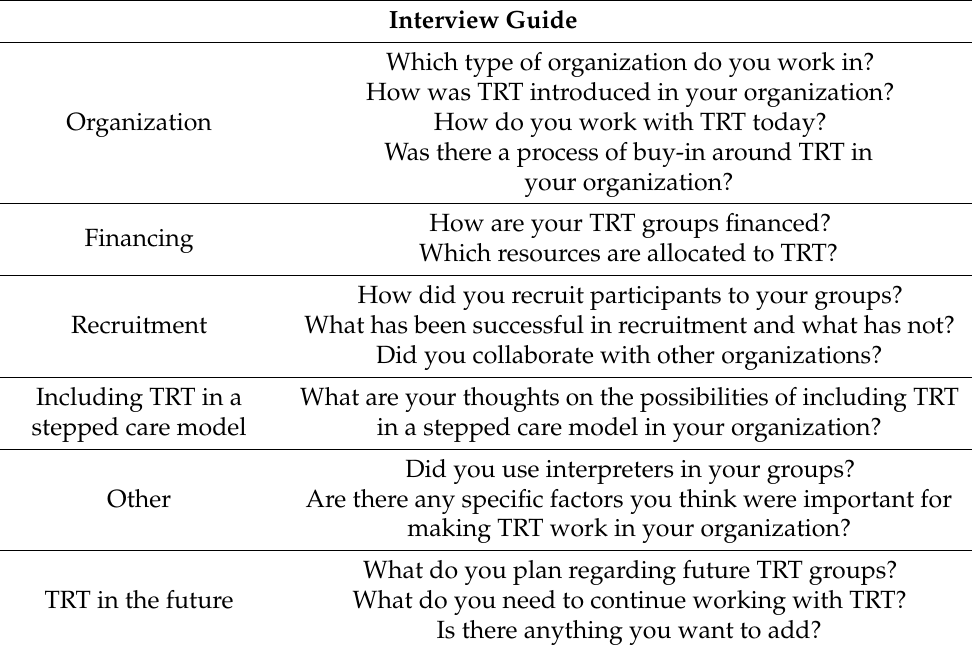
Table 3. Interview guide.